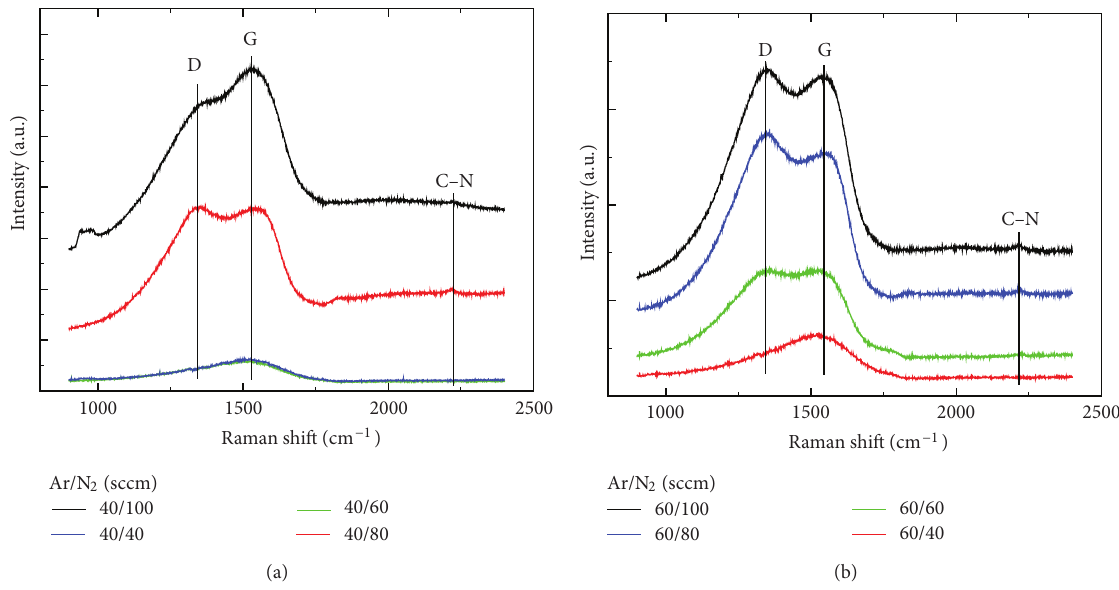
F 3: �aman spectra of a-C:N �lms deposited with constant Ar �ow and various N